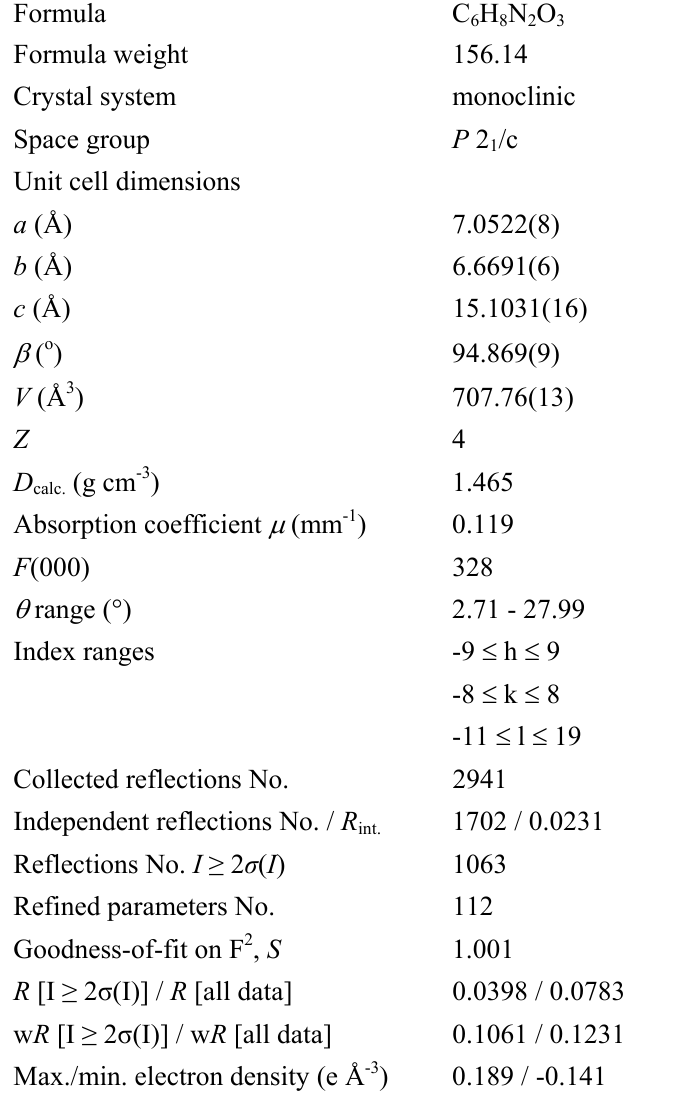
Table 3. X-ray crystallographic data for 2